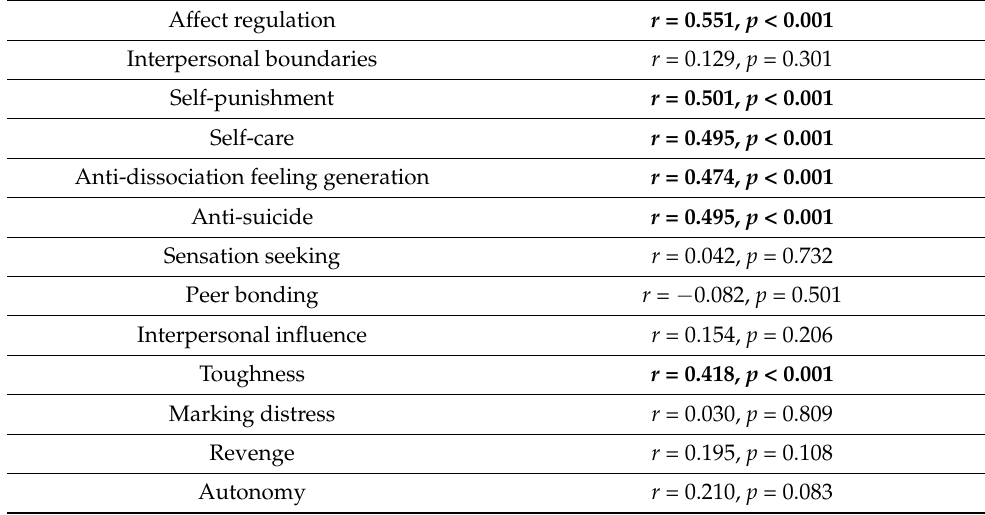
Table 2. Correlations between lifetime number of self-injuries and their